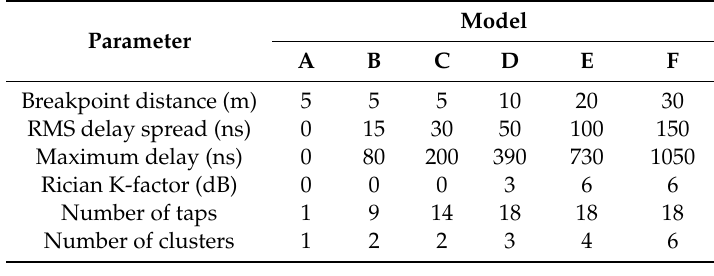
Table 3. IEEE 802.11 task group ac multipath fading channel.